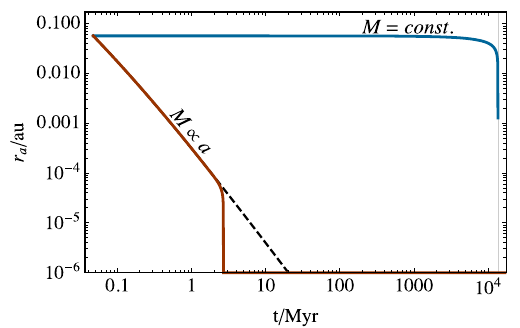
Fig. 1 The evolution of circular binary with M ∝ a (red) and M = const . (blue) from matter-radiation equality to the present day. r a = 0 . 057au at matter radiation equality and the present mass of the binary is 10 M (cid:3) . The dashed line is proportional to a −